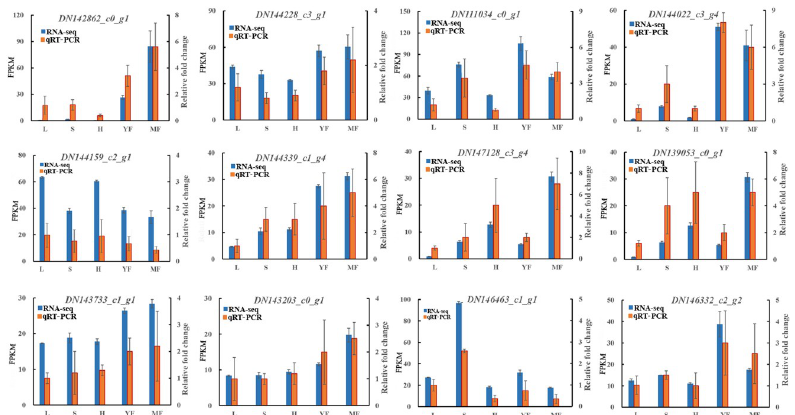
Fig 7. The relative expression levels of 12 randomly selected MYB by RNA-Seq and qRT-PCR. The horizontal axis indictes different tissues, including leaf (L), stem (S), flower (F), young fruit (YF) and mature fruit (MF). The left and right vertical axis individually indicate FPKM using RNA-seq and relative expression level using q RT-PCR. The error bars represent the standard deviation derived from each individual sample in triplicate.